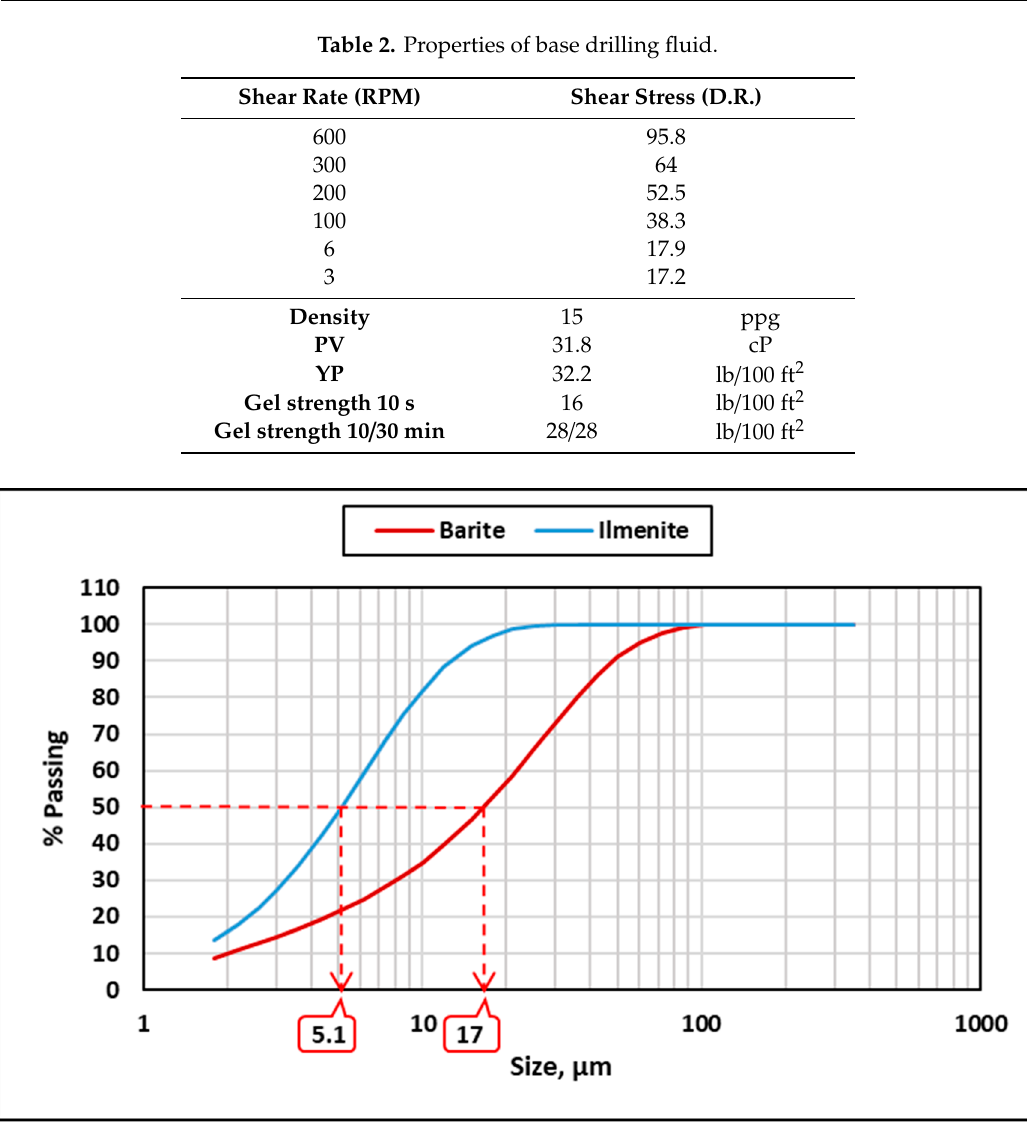
Figure 2. Particle size distribution for the used weighting materials.